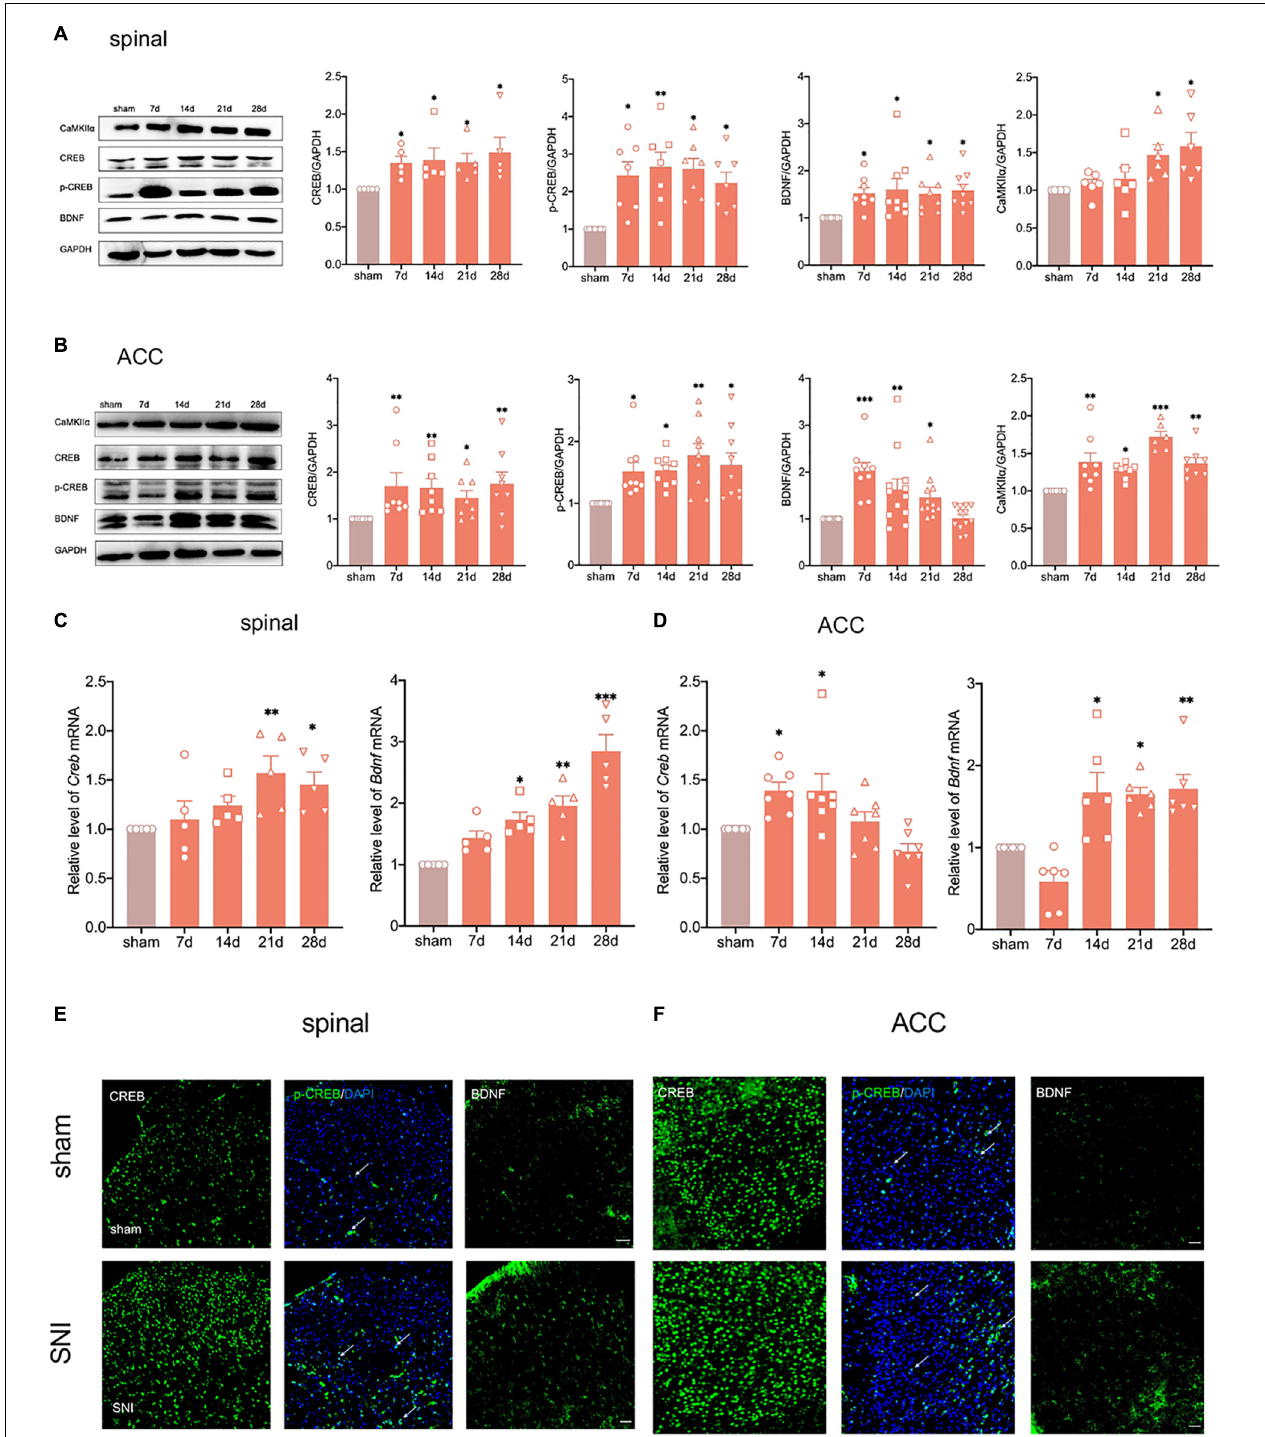
FIGURE 4 | Peripheral nerve injury activates the CREB/BDNF pathway in the spinal cord and ACC. (A) The expression of CREB, p-CREB, BDNF and CaMKII α was significantly increased in the ipsilateral spinal cord at all-time points (7, 14, 21, and 28 days) after the nerve injury in rats ( n = 8 rats/group). (B) The expression of CREB, p-CREB, BDNF and CaMKII α was significantly increased in the contralateral ACC at all-time points (7, 14, 21, and 28 days) after the nerve injury in rats ( n = 8 rats/group). (C) The expression of CREB mRNA and BDNF mRNA was significantly increased in the spinal cords of SNI rats ( n = 5 rats/group). (D) The expression of CREB mRNA and BDNF mRNA was significantly increased in the ACC of SNI rats ( n = 7 rats/group). (E,F) Immunofluorescence showed that peripheral nerve injury induced an increase in the expression of CREB, p-CREB, and BDNF in the ipsilateral spinal cord (E) and contralateral ACC (F) (Scar bar = 50 µ m). ∗ P < 0.05, ∗∗ P < 0.001, ∗∗∗ P < 0.0001 for sham vs.